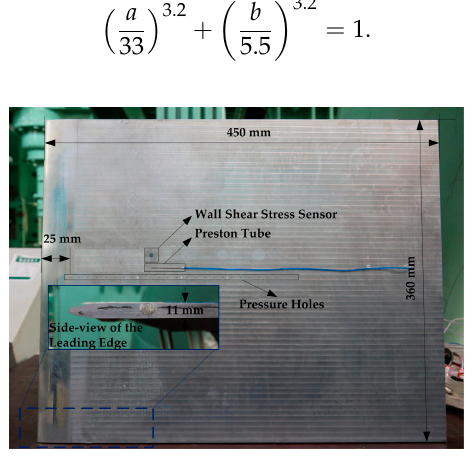
Figure 8. Picture of the plate model with an elliptic leading edge and the sensor installation.